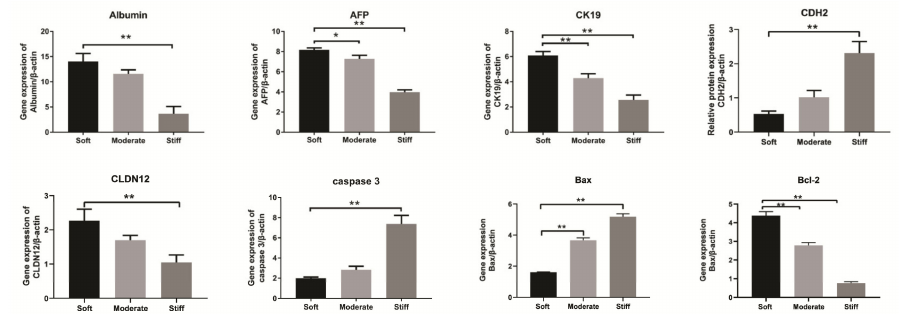
Figure 5. Gene expression was analyzed by RT-qPCR. Data are presented as the mean ± SEM ( n = 3). Moderate and sti ff groups compared to the soft group. * represents p < 0.05; ** represents p < 0.01.